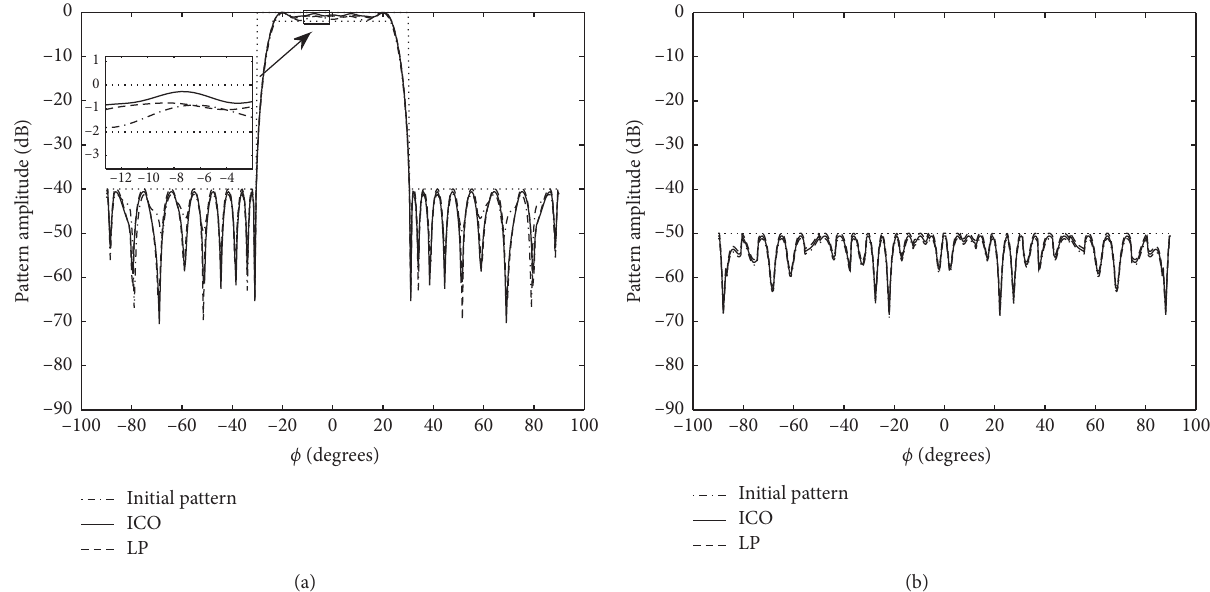
at θ � 90 ∘ . (b) Cross-polarization ϕ